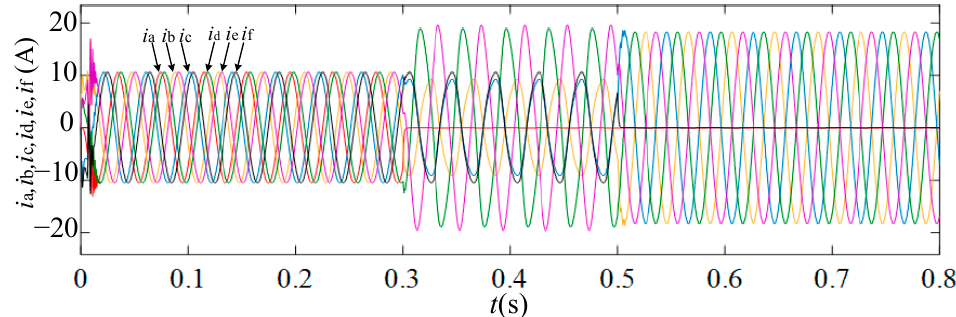
Figure 15. Current waveforms of phase a and phase f at 0.3 s and 0.5s open-circuit fault, respectively.